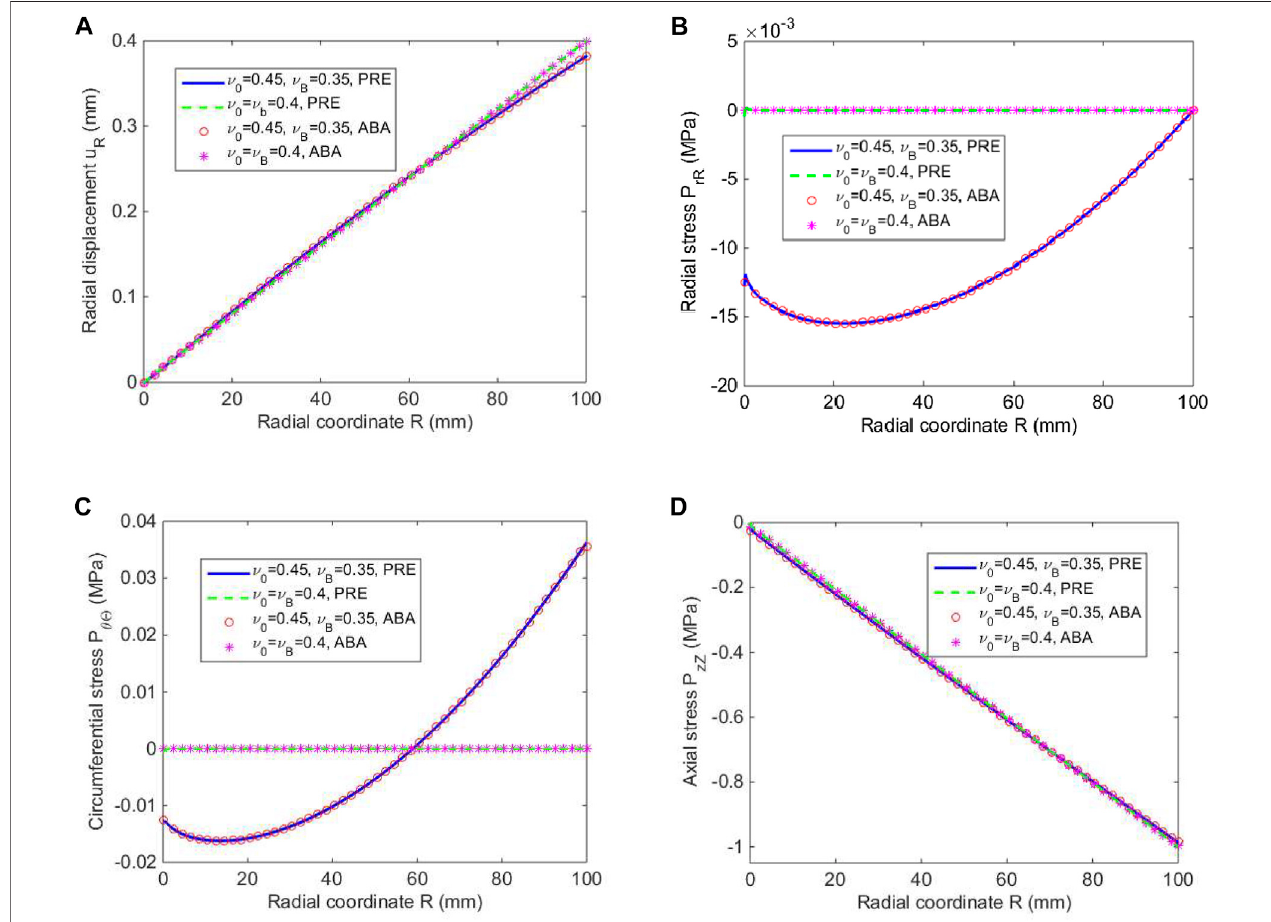
FIGURE2|(A) Radial displacement, (B) radialstress, (C) circumferential stress,and (D) axialstressvarying intheradial direction, obtained bythepresentmethod (PRE), for a solid cylinder under an axial strain ε 0 = − 0.01, in comparison with the results by ABAQUS (ABA).